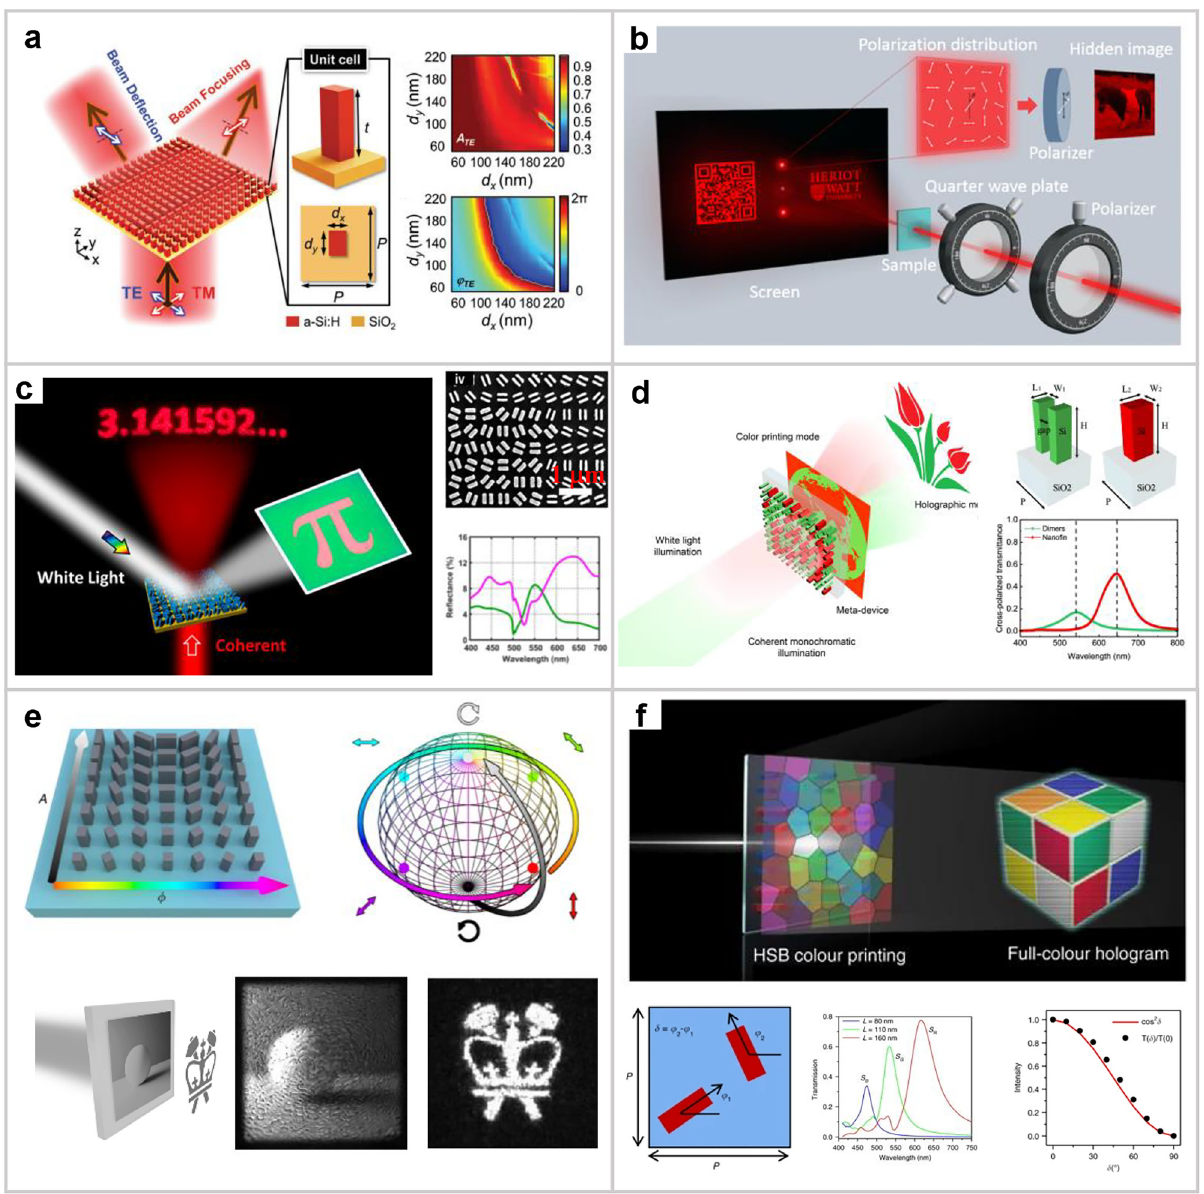
Figure 8: Applications of polarization-based multifunctional devices with all-dielectric metasurfaces. (a) A linear polarization-switchable bi- functional metasurfacefor anomalous beamdeflectionandfocusing inthe visibleband basedonpropagationphase[122].(b)Multiplexingof nano-printing and chirality-dependent holography with interleaved geometric phase meta-atoms [123]. (c) A dual-mode geometric phase- basedSimetasurfacesthatenablecontrolofphaseandspectralresponsessimultaneousforcolorprintinginre fl ectionmodeandholography in transmission mode [124]. (d) A two-color nano-printing and holography in one Si metasurface by designing two geometric phase-based nanostructures with wavelength-sensitive polarization conversion ef fi ciency [125]. (e) A Si metasurface with the capability of complete amplitude and phase control for monochromatic grayscale nano-printing and far- fi eld holography [126]. (f) A crystal Si metasurface to simultaneously realize nano-printing with continuous HSB color tuning and full-color holography [127]. Reprint permission obtained